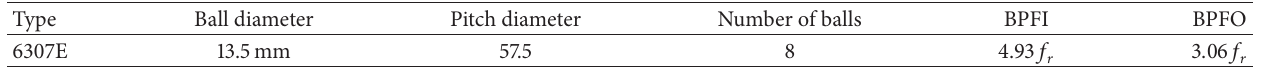
Figure 10: The details of the order envelope demodulation spectrum. (a) The order-axis display range is [0,1.5] ; (b) the order-axis display range is [0,5] . Table 1: Parameters of the faulty bearings.